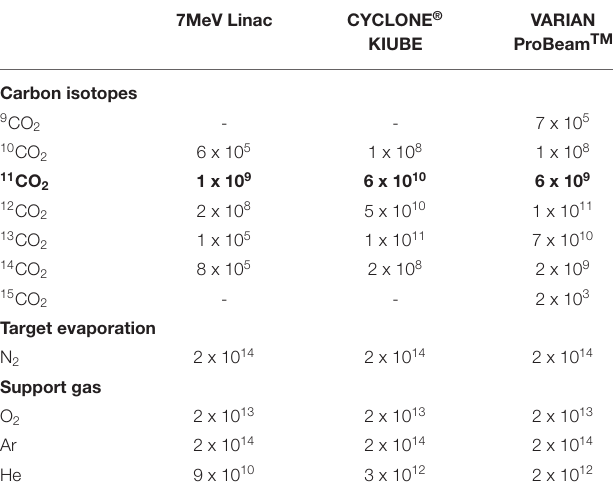
TABLE 4 | Gas output (molecules per second ) from the BN target before separation: 11 C molecular compounds (in bold) and the corresponding